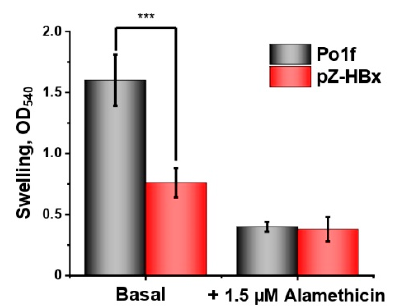
Figure 7. Membrane depolarization of Y. lipolytica mitochondria by palmitate. The basic incubation medium was supplemented with 20 mM safranine O and mitochondria (0.5 mg protein/mL). Swelling of mitochondria is an energy-dependent process. Amplitude of swelling (normalized on protein content) of mitochondria from HBx-expressing cells was approximately two times lower compared to those from the control variant (Figure 8). The poroformer alamethicin, forming pores of 1 nm in diameter in the membrane and causing maximal swelling of mitochondria [74], was taken as a negative control.